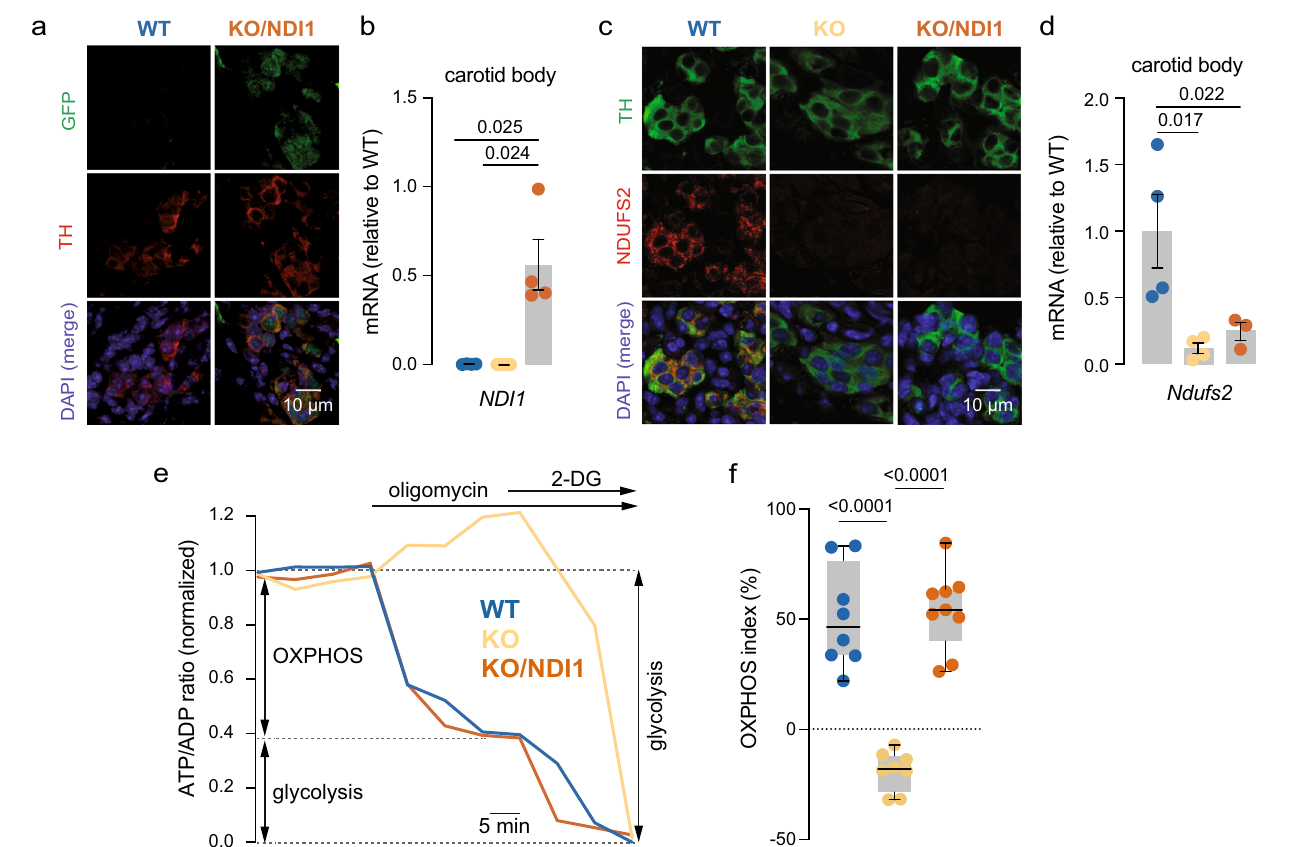
Fig.2|NDI1expressionandmitochondrialbioenergeticrestorationincomplex I-de fi cient carotid body glomus cells. a Histological sections of the carotid body (CB) from WT (left) and KO/NDI1 (right) mice illustrating colocalization of NDI1 expression (green fl uorescent protein, GFP) and tyrosine hydroxylase (TH). DAPI was used to stain nuclei. Similar immunocytochemical studies were performed in n =4 mice for each genotype. Calibration bar (10 μ M) applies to all panels. b NDI1 mRNA levels, relative to WT, in CB samples from WT mice (blue dots, 0.030±0.0009, n =4 replicates/group), KO mice (yellow dots, 0±0, n =4 repli- cates/group) and KO/NDI1 mice (brown dots, 0.56±0.14, n =4 replicates/group). Dataareexpressedasmean±SEM.Pvaluescalculatedbyone-wayANOVAfollowed byNewman-Keulsmultiplecomparisonstestareindicated. c ImmunostainingofCB sections illustrating NDUFS2 protein expression in THpositive cells from WT mice (left)andthedisappearanceinCBcellsfromKO(middle)andKO/NDI1(right)mice. Similar immunocytochemical studies were performed in n =4 mice for each gen- otype. Calibration bar (10 μ M) applies to all panels. d Ndufs2 mRNA levels, relative to WT, in CB samples from WT mice (blue dots, 1±0.3, n =4 replicates/group), KO